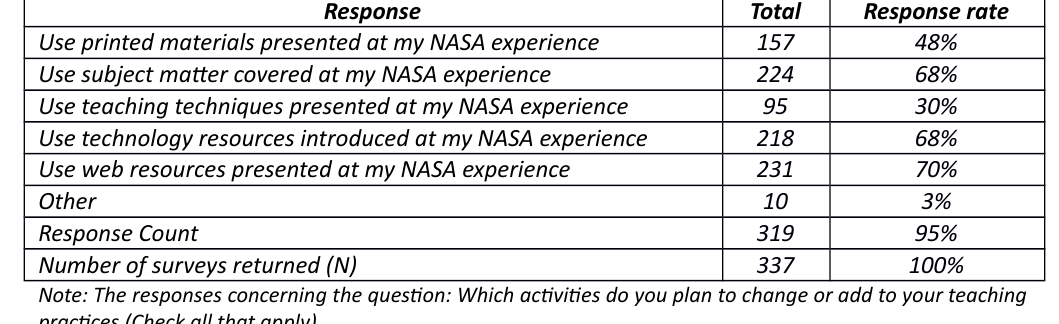
Table 5. Cumulatve results from partcipants in ICCARS actvites from the NASA Educator End of Event Surveys